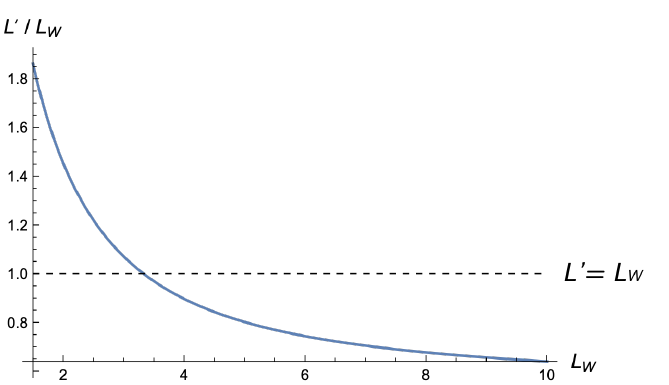
. The dashed line labels 1